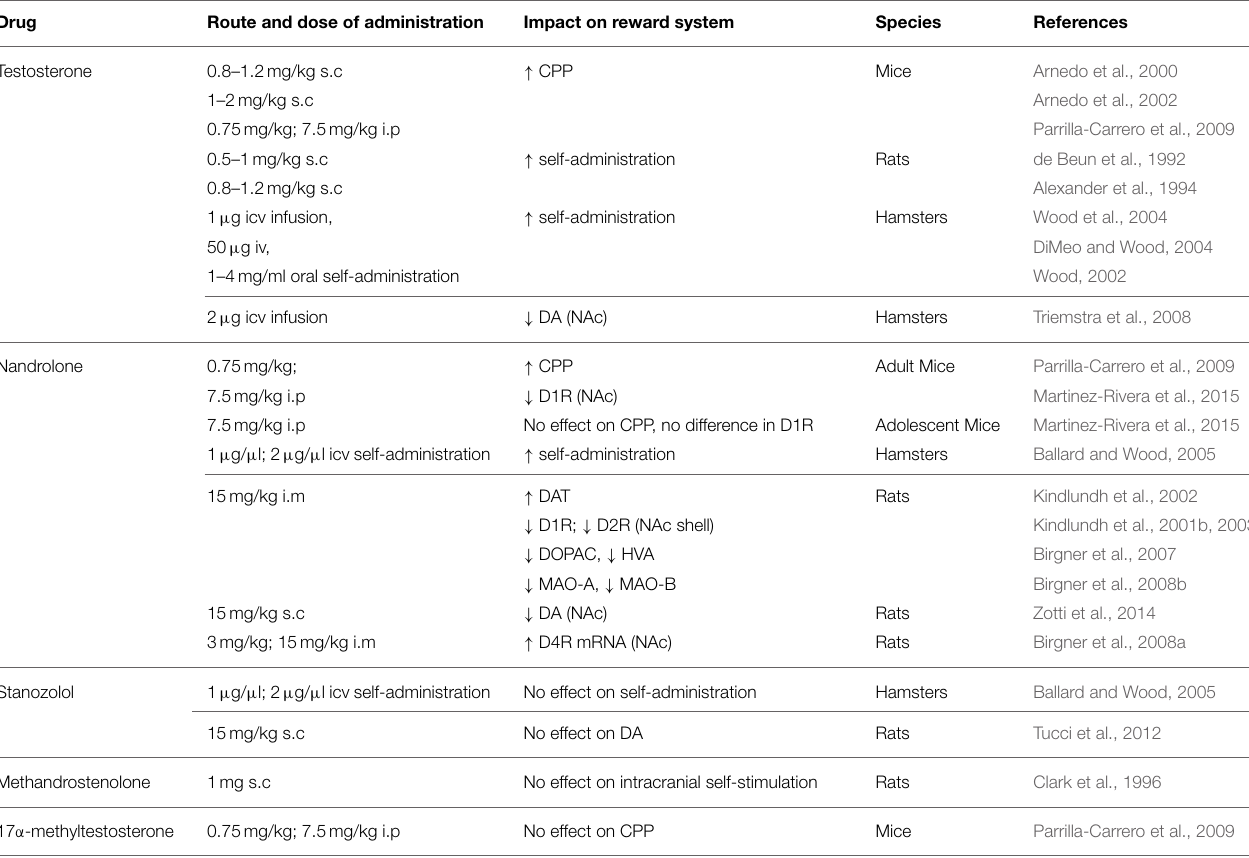
TABLE 1 | Preclinical overview of the impact of different AAS on reward